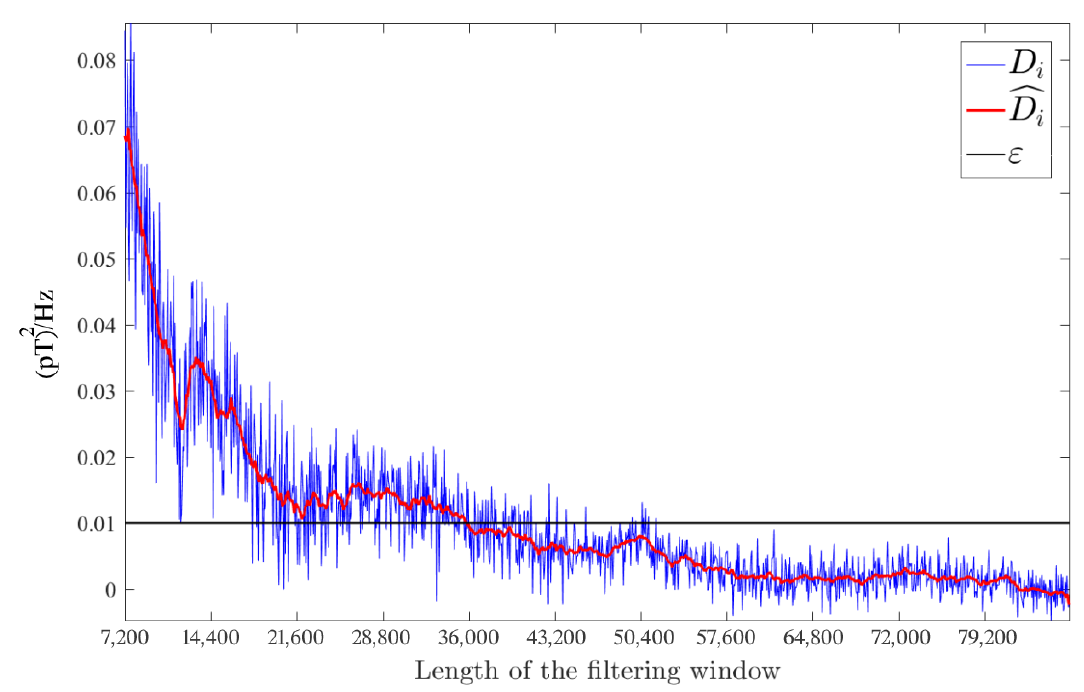
Figure 1. The original D i (blue line) and smoothed (cid:99) D i (red line) discrete derivative of the difference between standard deviations of filtered and non-filtered data. The degree of tolerance used in this study was set to ε = 0.01 (black line). Thus, the optimal size of the filtering data window was selected as the maximal data window satisfying (cid:99) D i > ε . It can be observed from this figure that the optimal length filtering data window corresponding to such criteria is 36,000 elements, i.e., 10 h of local magnetic field spectral power